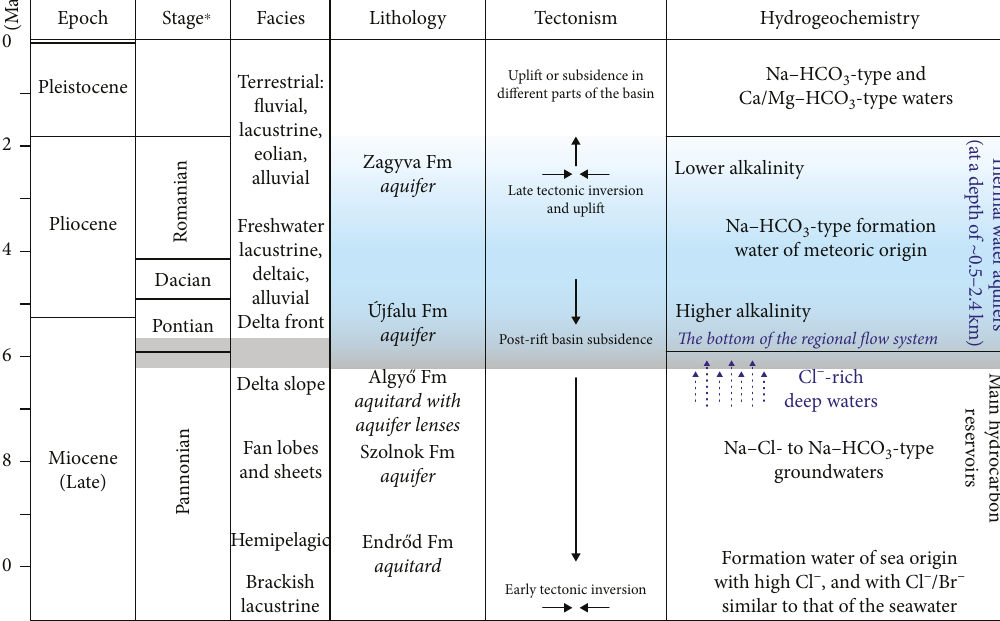
Figure 5: Summarized geological and geochemical information for the studied aquifers [9, 14 – 18, 25, 28 – 30]. Thermal water aquifers are indicated by a blue bar. Gray rectangle indicates the estimated bottom of a regional fl ow system (Pannonian/Pontian boundary) [9]. Note: hydrogeochemical interpretations do not re fl ect the deposition of diachronous and laterally variable formations. Additionally, the Pannonian Basin is regarded as a nonuniform multilayer fl ow system in this conception. Abbreviation: Fm =Formation. ∗ Central Paratethys